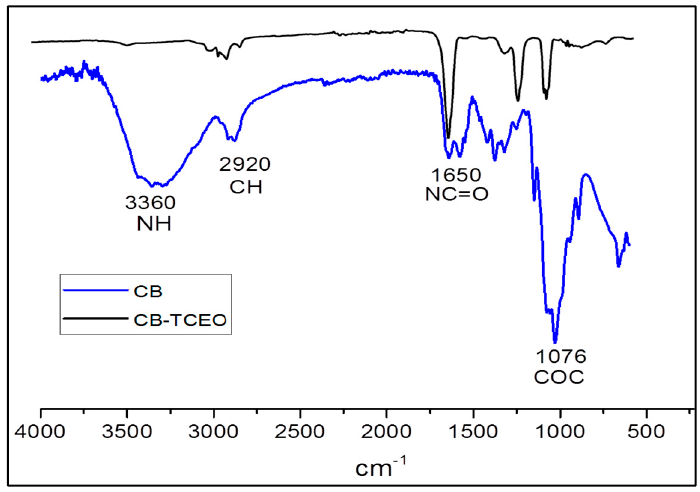
Figure 3. FTIR image of the chitosan beads (CB) and chitosan beads incorporating essential oil (CB-TCEO).